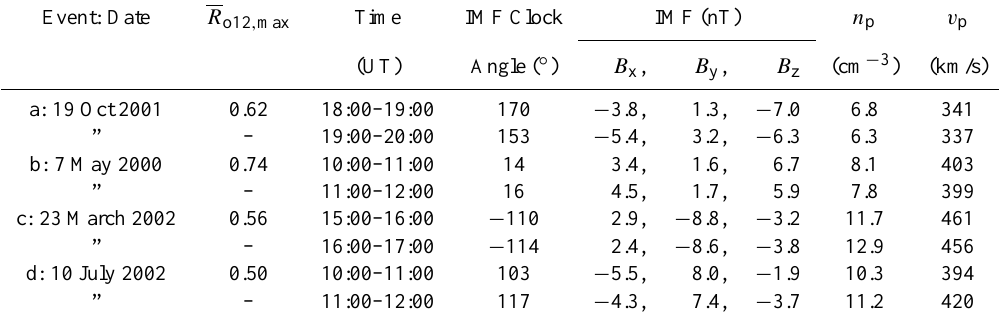
Table 1. Current region overlap fraction and average solar wind and IMF parameters for the intervals of Fig. 1. All ACE data are lagged using simple advection. The clock angle is evaluated from the average vector projection in the Y - Z GSM